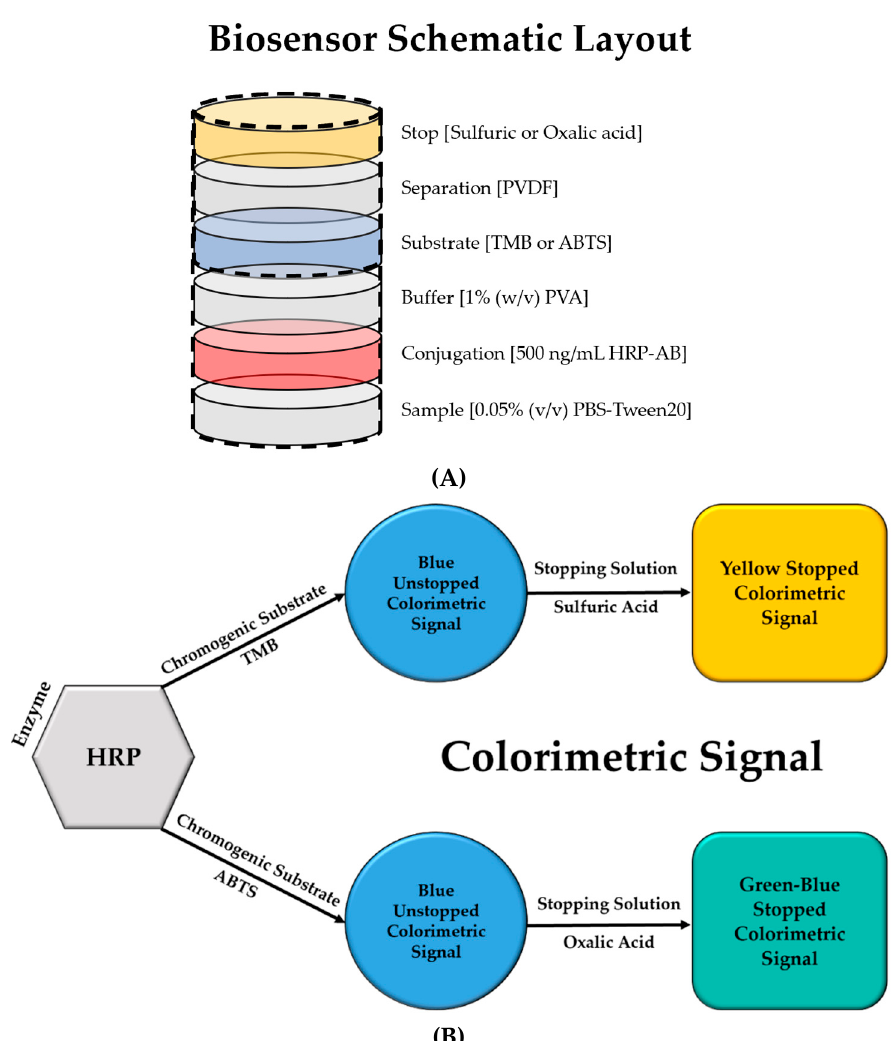
Figure 1. Biosensor schematic description. ( A ) The detection of stopped colorimetric signal on membrane was examined using ‘Stack-Pad’ sensor layout [21,22]. ( B ) The colorimetric signal was generated based on the reaction of the enzyme horseradish peroxidase (HRP) with the chromogenic substrates 3,3’,5,5’-tetramethylbenzidine (TMB) and 2’-azinobis (3-ethylbenzothiazoline-6-sulfonic acid) (ABTS). Sulfuric acid and oxalic acid were used as the stopping solutions for TMB and ABTS respectively.